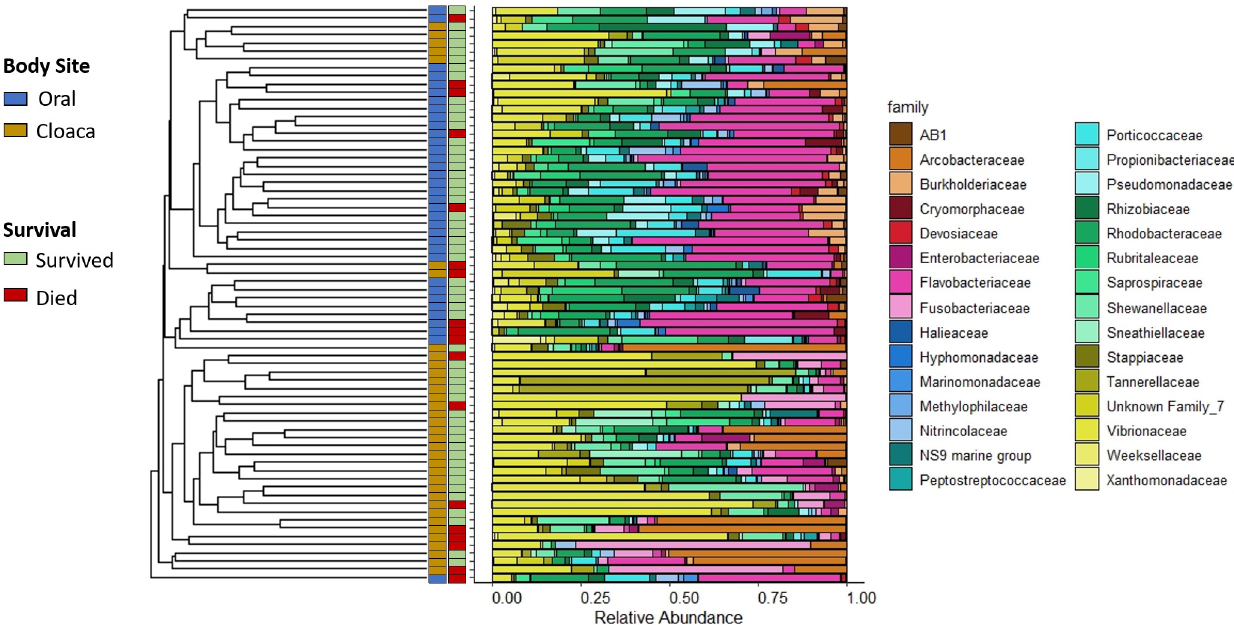
Fig 2. Turtle microbial communities at intake. Hierarchical clustering of intake samples is shown as the dendrogram on the left, with the tips each representing a sample. On the right are the corresponding stacked bar plots representing relative abundance of community composition at the family level (top 30 families). Colored bars at the center specify body site (left bar) and survival (right bar) corresponding to each sample.